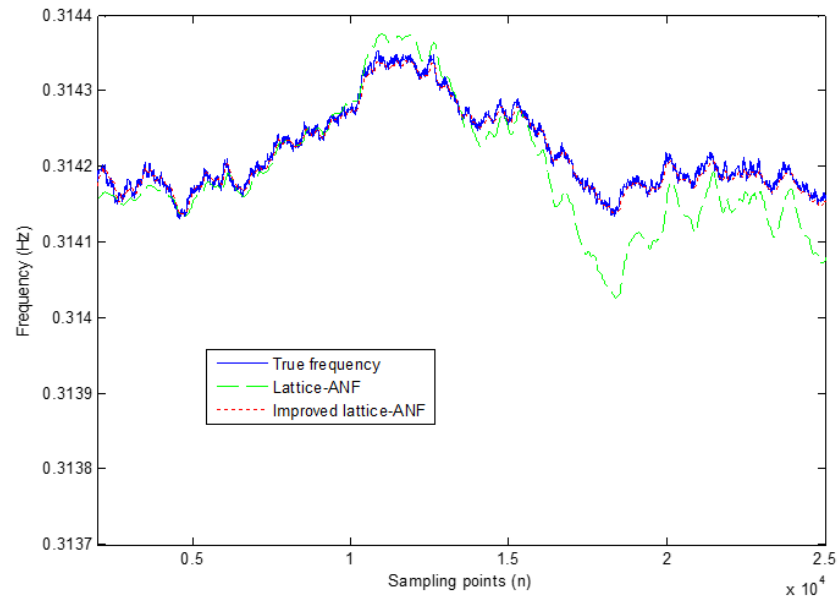
Figure 2. Frequency estimated by ALNF and modified ALNF.